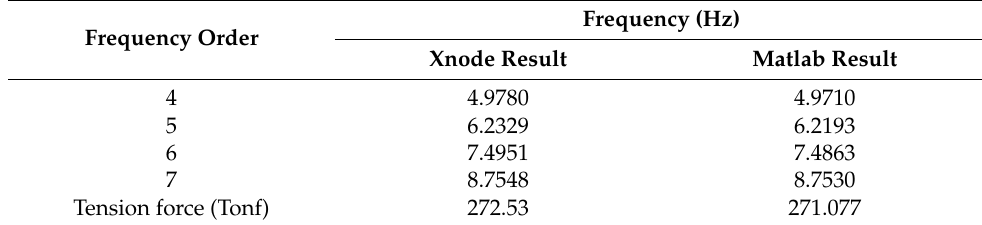
Table 2. Frequency and cable tension force of cable#64.